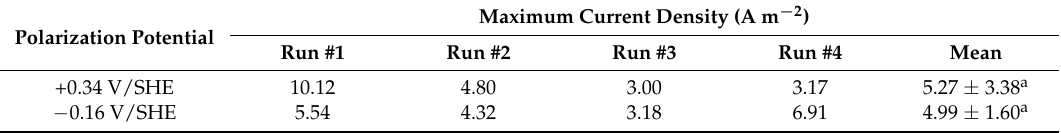
Table 3. Maximum power density recorded by linear voltammetry after 21 days of polarization at +0.34 V/SHE and − 0.16 V/SHE